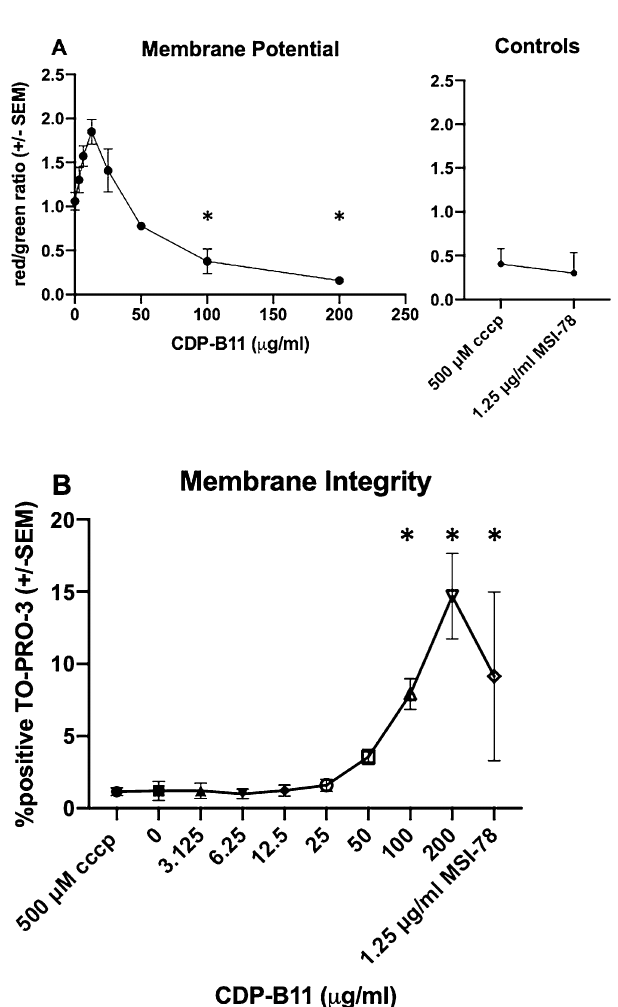
Figure 1. Assessment of membrane integrity. ( A ) Red/green ratio of cells relative to differing concentrations of CDP-B11. Both CCCP (500 µM) and peptide MSI-78 (1.25 μg/mL) were used as positive controls. ( B ) Fluorescent signal of cells treated with peptide CDP-B11. Higher signal corresponds to greater membrane damage. CCCP was used as a negative control because it reduces membrane potential without causing membrane damage. MSI-78 (1.25 μg/mL) served as a positive control for membrane damage. Results were analyzed using one-way ANOVA correcting for multiple comparisons using a post hoc Dunnett’s correction for multiple comparisons ( P < 0.05).